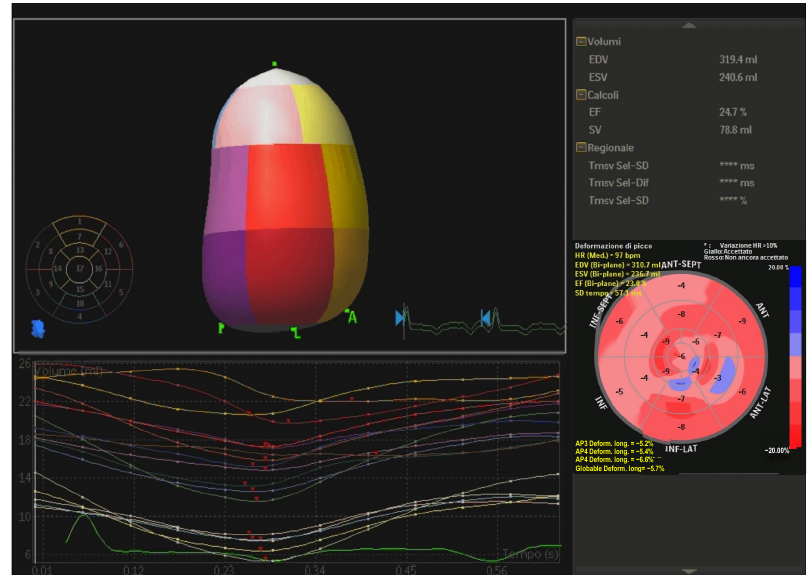
Figure 1. LVEF obtained with 3D echocardiography and GLS measurements in a patient with DCM. In the 3D reconstruction different colors indicates different LV segment. In the Bull’s eye display of GLS intense shades of red indicate optimal GLS values (− 20%), while less intense shades, white color and different intensities of blue indicate sub-optimal and pathological GLS values (+20%). EDV= end-diastolic volume; ESV= end-systolic volume; EF= ejection fraction; SV= stroke vol- ume, HR = heart rate, GLS = global longitudinal strain; DCM= dilated cardiomyopathies.